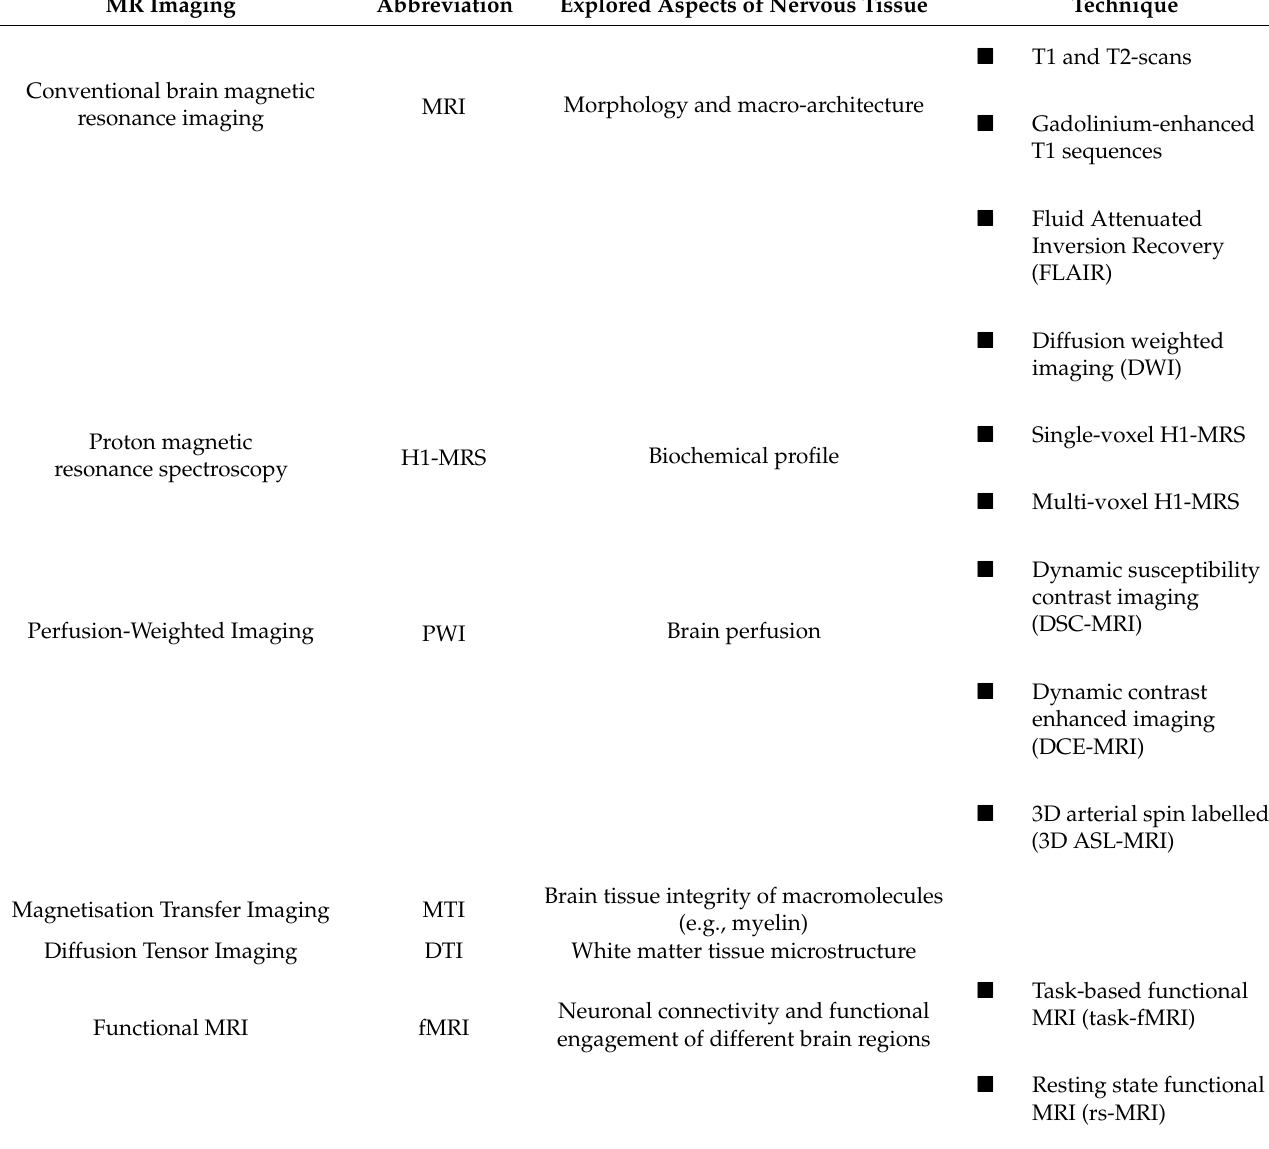
Table 1. Main MRI techniques adopted for NSPLE assessment and clinical